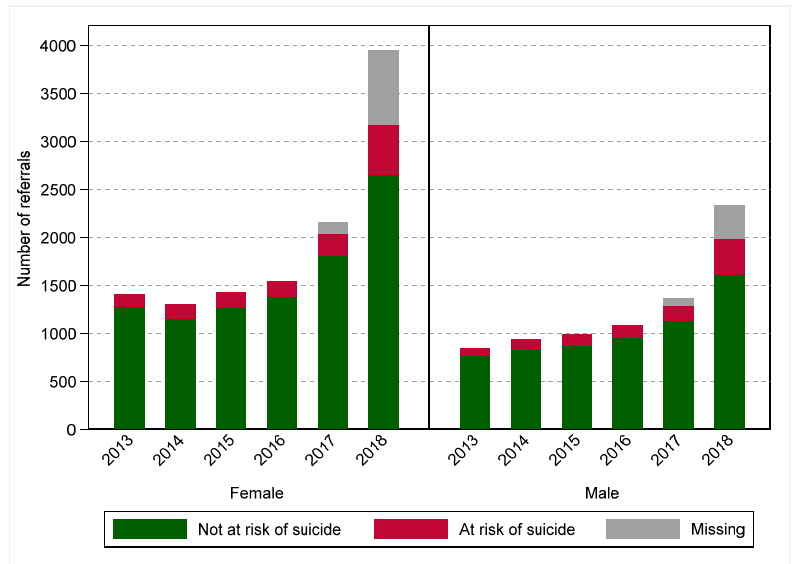
Figure 1. Number of referrals to primary mental health care (PMHC) services by gender, Western Sydney Primary Health Network, 2013–2018. Referrals with a missing suicide risk flag were considered as suicide referrals for those who received suicide-prevention-specific services (there were 222 referrals with missing suicide flags, which were replaced due to being at risk of suicide). Int. J. Environ. Res. Public Health 2022 , 19 , x There were 264 (2.2%) clients presenting with cases of hospital-treated self-harm who